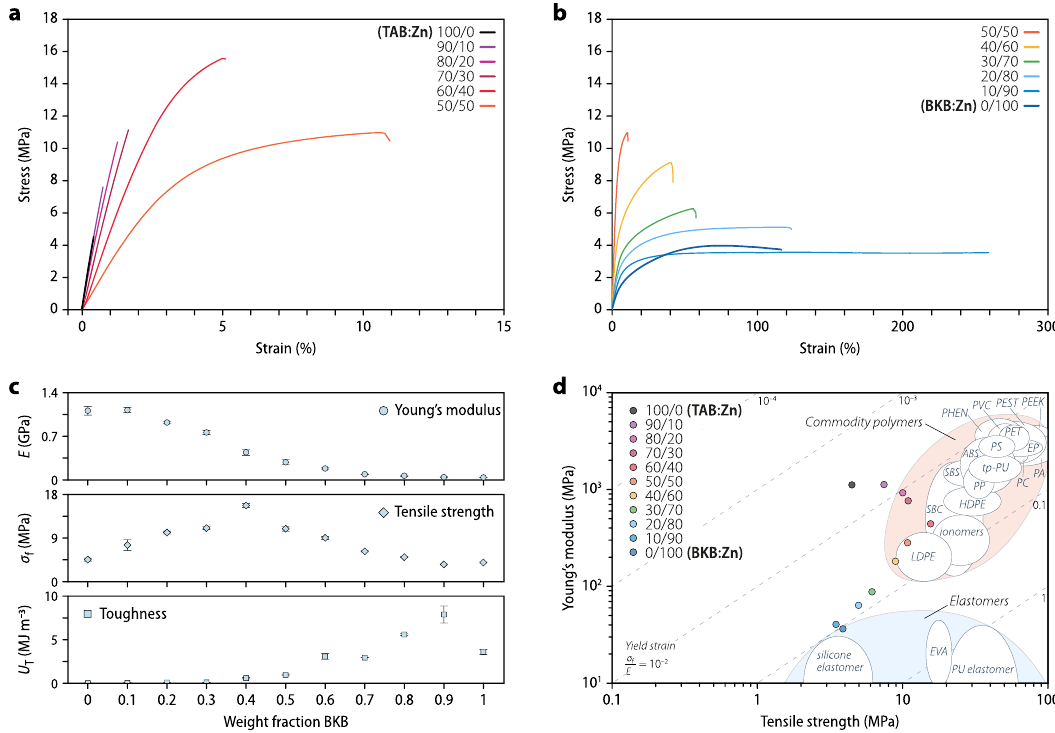
Fig. 3 Mechanical properties of the two MSPs and their copolymers. a , b Representative stress – strain curves of the metallosupramolecular polymers TAB:Zn, BKB:Zn, and their copolymers TAB/BKB:Zn with the indicated TAB/BKB weight ratio (wt/wt%). c Plots of the Young ’ s modulus ( E ), tensile strength ( σ f ), and toughness ( U T ) of samples as a function of the weight fraction of BKB. Data represent averages of n = 3 – 7 individual measurements with standard deviation. d Ashby (materials selection) plot showing the Young ’ s moduli and tensile strengths of the MSPs and copolymers and the properties attainable with some elastomers and commodity polymers 41, 42 .